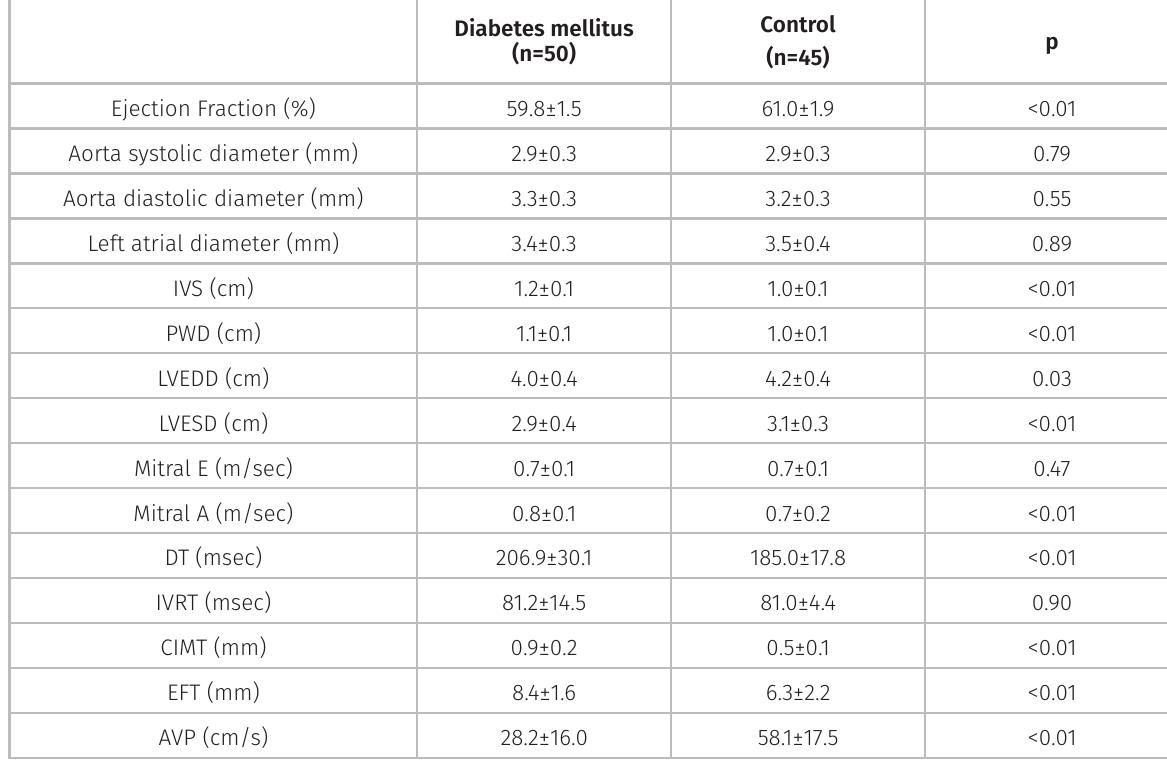
IVS. interventricular septum; PWD, posterior wall diameter; LVEDD, left ventricular end-diastolic diameter; LVESD, left ventricular end-systolic diameter; Mitral E, early diastolic mitral flow velocity; Mitral A, late diastolic mitral flow velocity; DT, deceleration time; IVRT, isovolumic relaxation time; CIMT, carotid intima-media thickness; EFT, Epicardial fat thickness; AVP, Aortic velocity propagation. p value was calculated by the student’s t test. Results were presented as Mean ±SD. p<0.05 was considered statistically